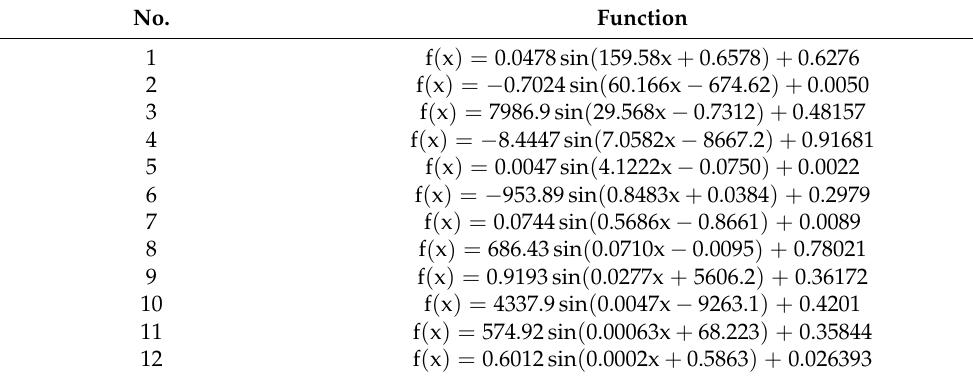
Table 10. Test function.